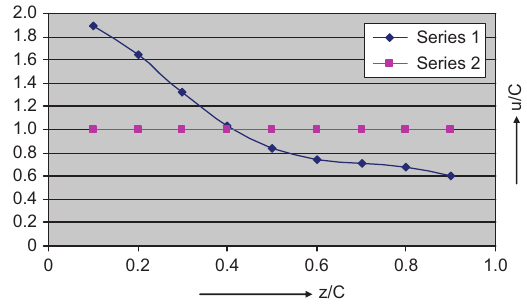
Figure 2 Displacement pattern for square wave input.